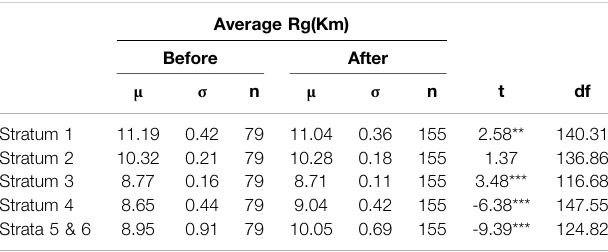
TABLE 5 | Average Radius of Gyration in KM mean difference t -test. Before time period is Jan/01 – Mar/20. After period is Apr/27 – Oct/12. Average